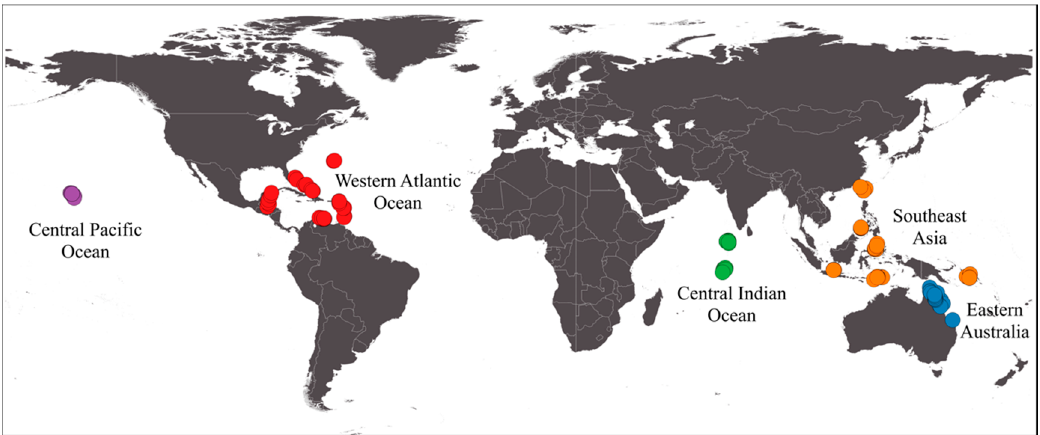
Figure 1. Global bioregions where the performance of automated image annotation was evaluated. Each region is comprised of surveys in multiple countries and reef locations represented by the filled dots colour-coded according to the survey region (Table 1). Base map source: Reef at Risk revisited (base map, www.wri.org / publication /